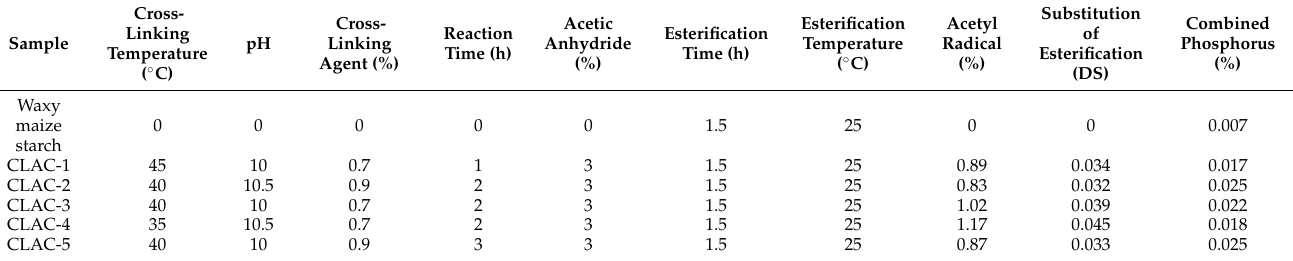
Table 1. Preparation conditions, acetyl content, and bound phosphorus content of